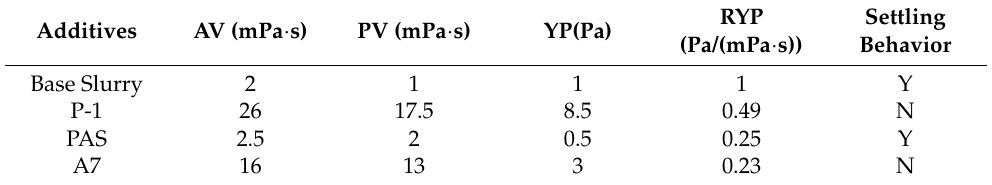
Table 2. Rheology and stability of the slurry after adding the examined synthetic polymers.